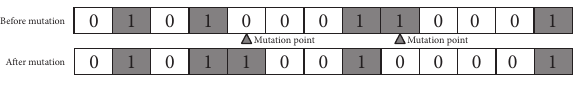
Figure 2: Two-point mutation